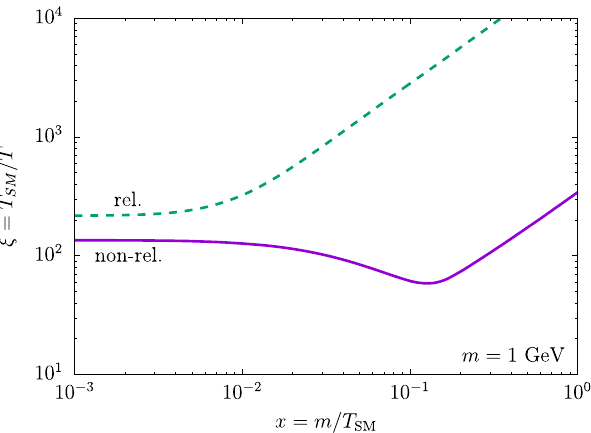
Figure 6 . Evolution of ξ = T SM /T for relativistic and non-relativistic freeze-out. Dashed curve: λ = 0 . 1 and m/T f = 0 . 92; solid curve: λ = 10 and m/T f = 7 .